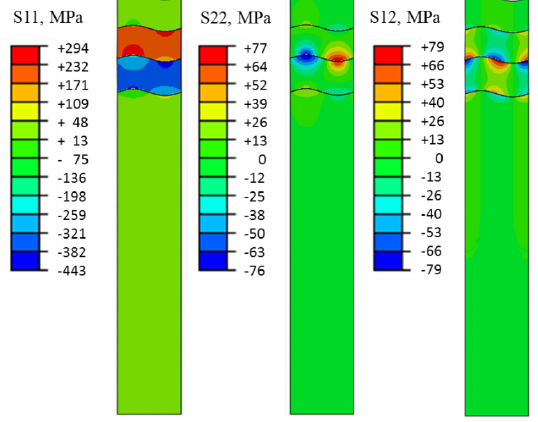
Coatings 2020 , 10 , x FOR PEER REVIEW Figure 4. The contours of thermal residual stress in coated CMCs after processing.